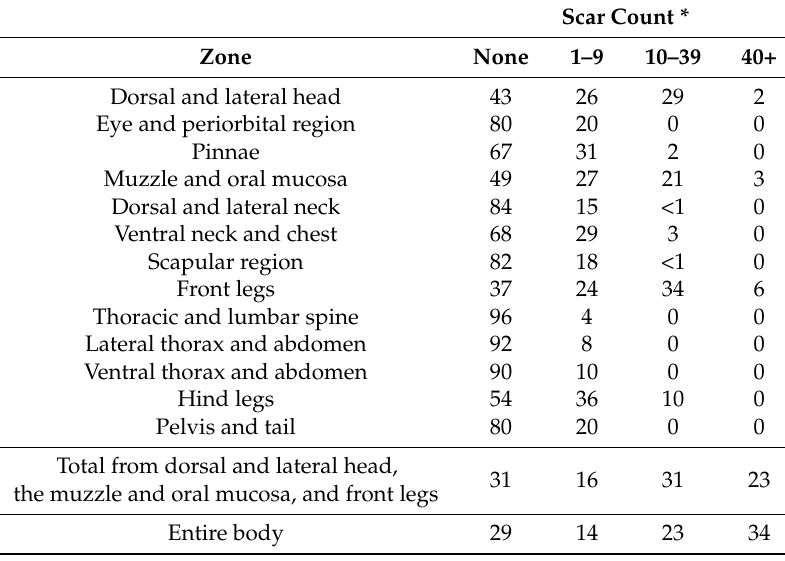
Table 3. Scar count by body zone. Data indicate the percentage of dogs having the indicated scar count in each zone (N =